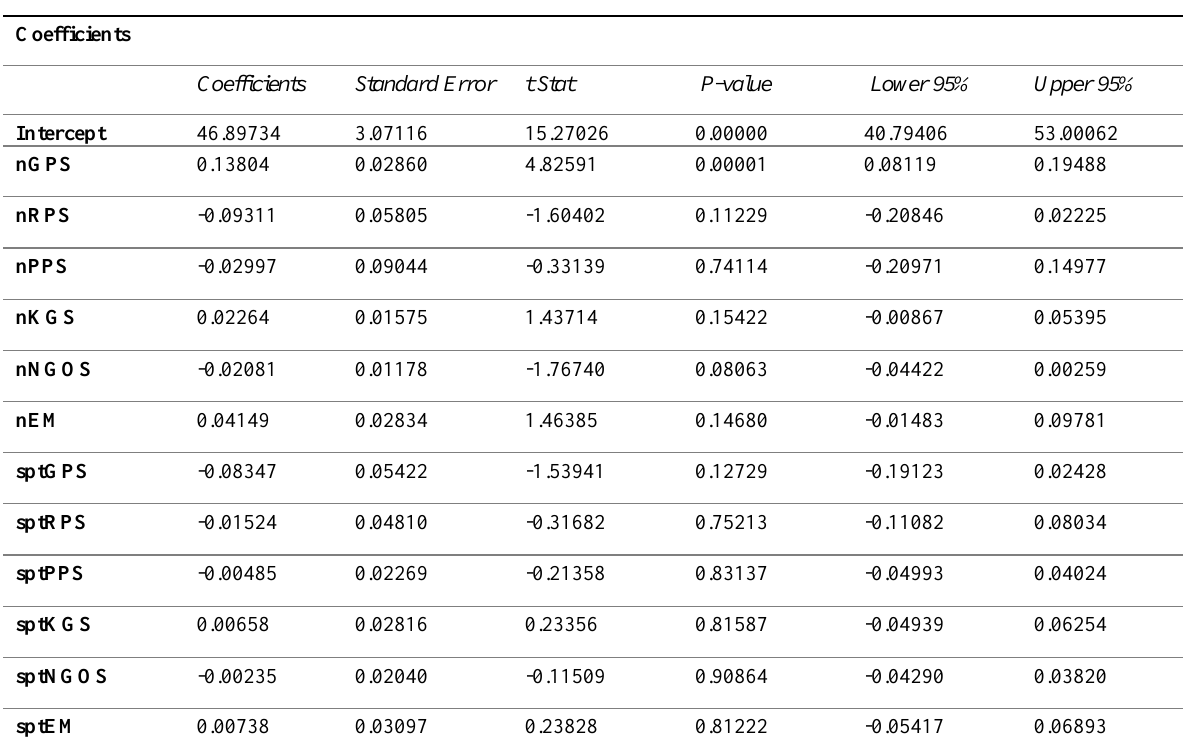
Table 9: Coefficients (Chittagong